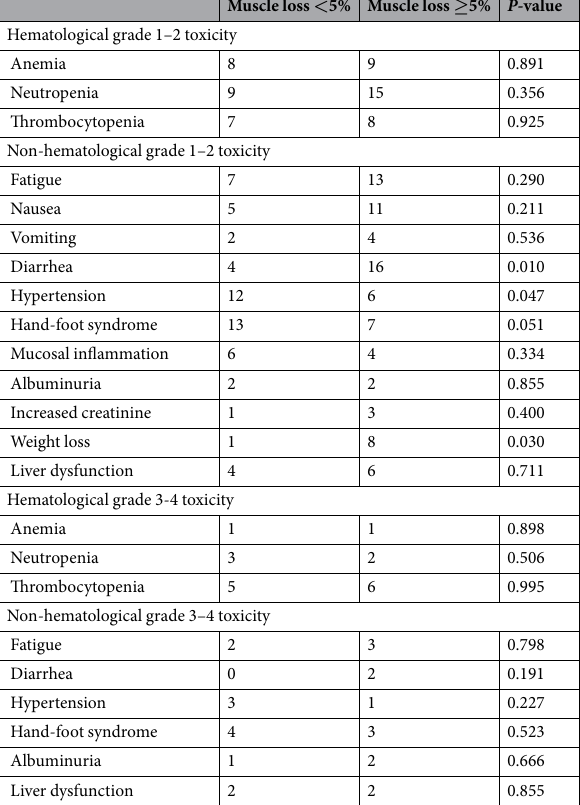
Table 4. Common adverse events collected during targeted therapy * . * CTCAE